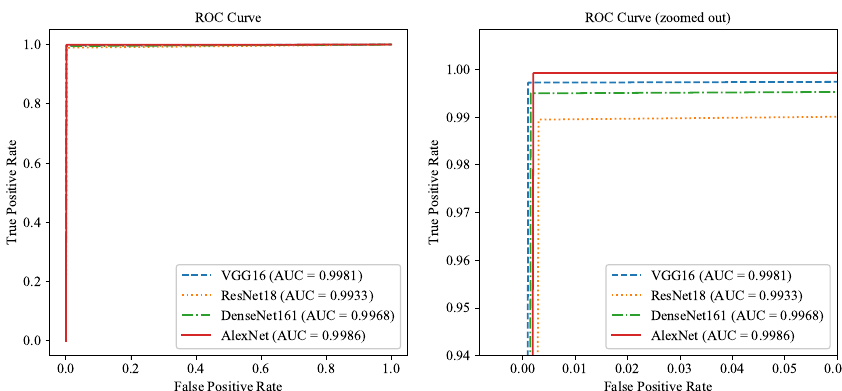
Figure 13. ROC curve of different TL models.